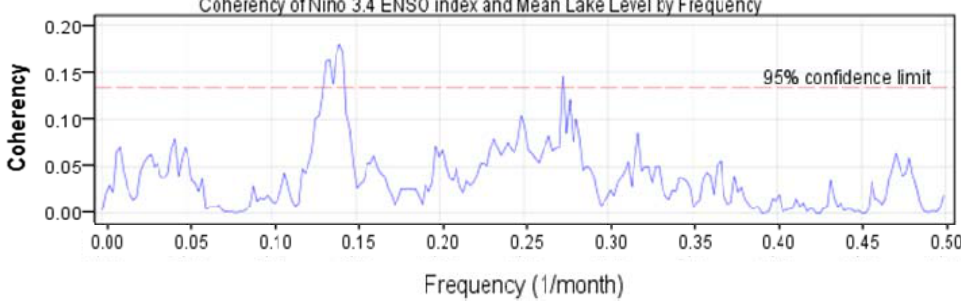
Figure 8. Coherence between ENSO index and lake level variability in frequency domain.